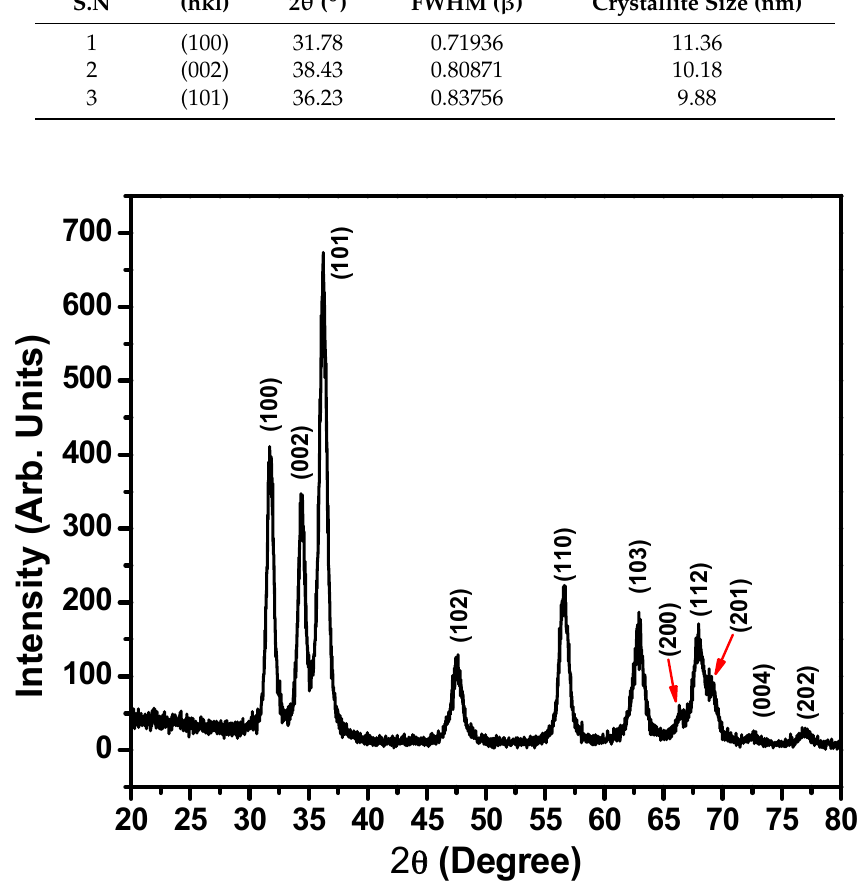
Figure 2. Typical XRD patterns for hydrothermally synthesized ZnO nanoballs.